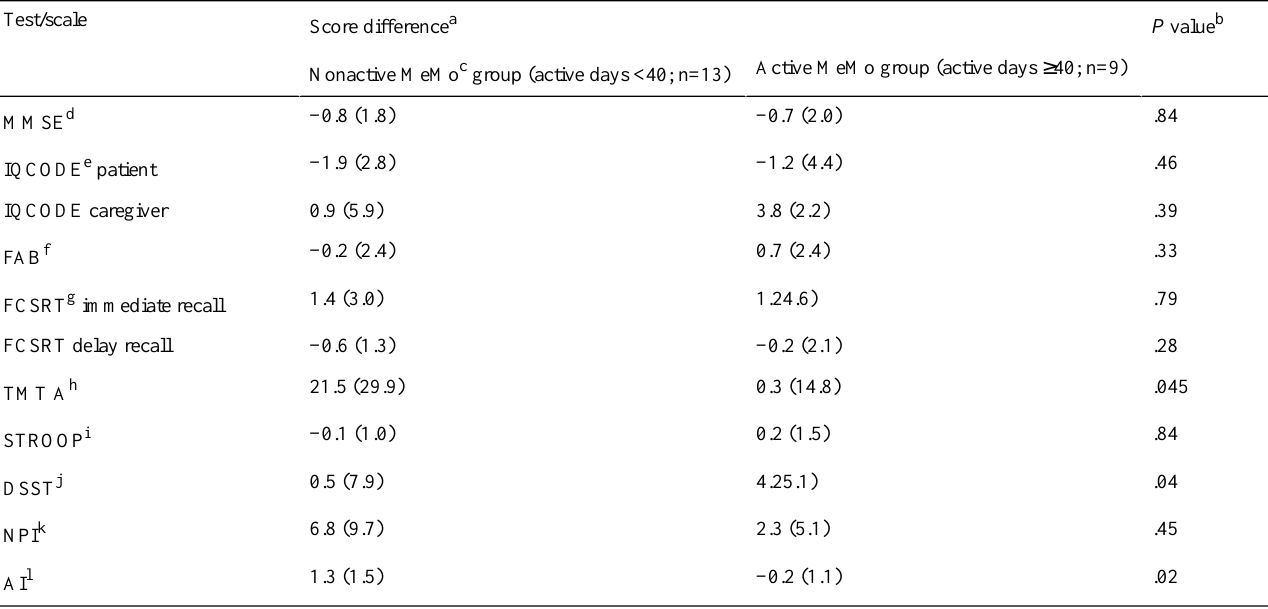
Table 2. Cognitive and behavioral score changes between baseline and week 12 in the active MeMo group and nonactive MeMo group.